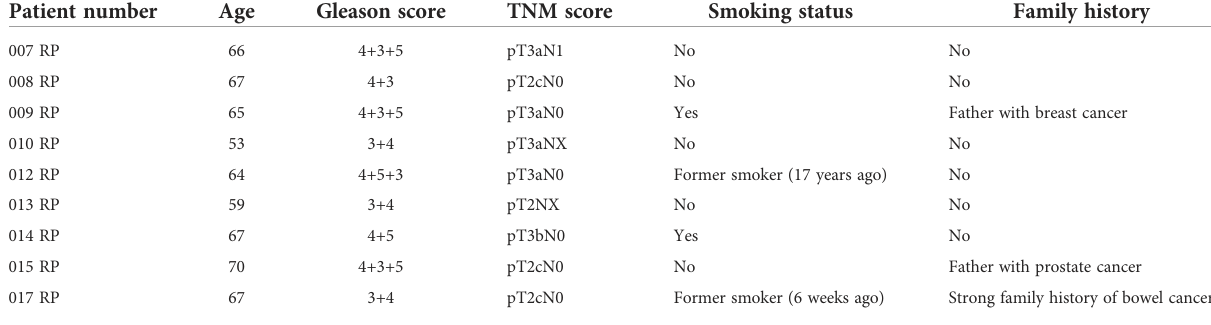
TABLE 1 Patient characteristics of the paired Clariom D sample